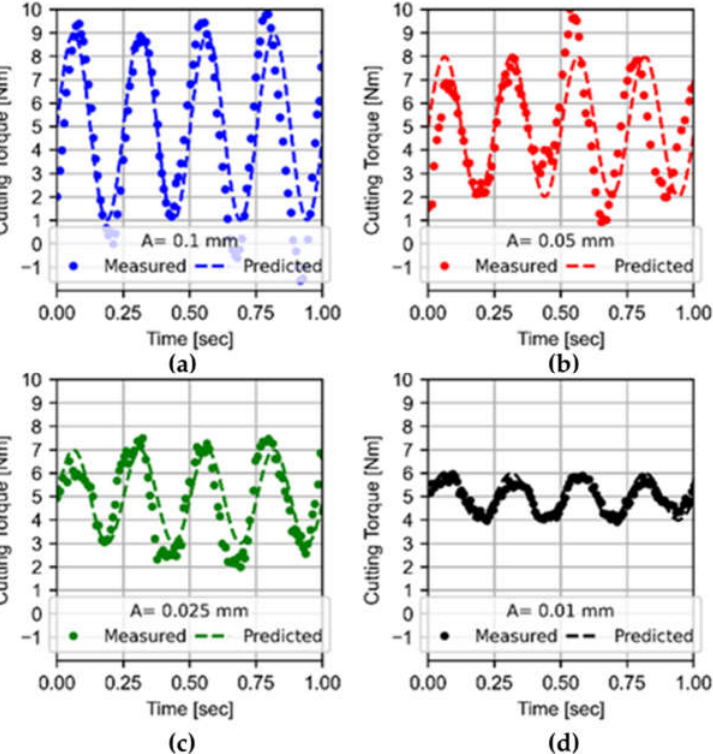
Figure 12. Measured and predicted torques of LFAB processes with vibrational conditions. A = 0.1 mm and different frequencies ( a ) f = 0 Hz, ( b ) f = 1 Hz, ( c ) f = 2 Hz and ( d ) f = 4 Hz; tests 23–26 in Table